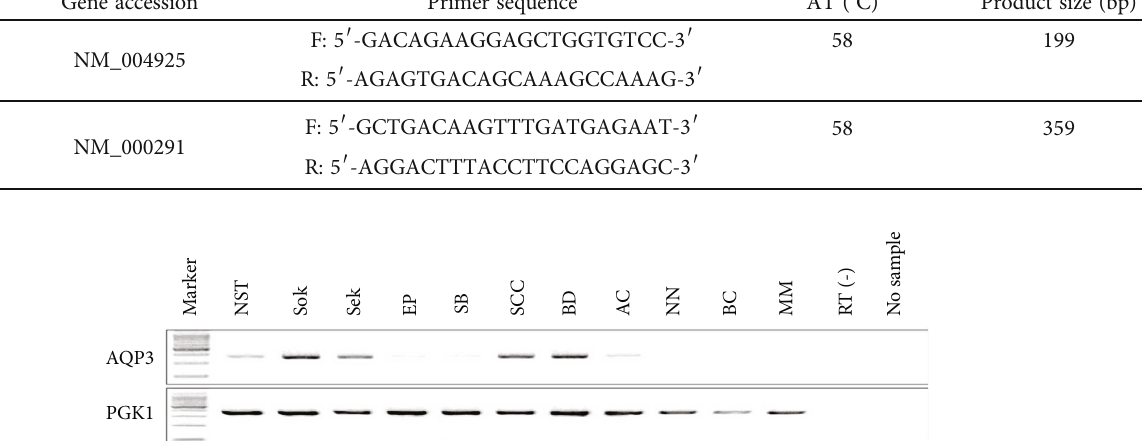
Figure 1: AQP3 mRNA level in skin normal tissue and lesions. RT-PCR showed AQP3 mRNA in normal squamous tissue (NST), solar keratosis (SoK), seborrheic keratosis (SbK), eccrine poroma (EP), sebaceoma (SB), squamous cell carcinoma (SCC), Bowen ’ s disease (BD), and apocrine carcinoma (AC), but AQP3 mRNA was absent in nevocellular nevus (NN), basal cell carcinoma (BC), and malignant melanoma